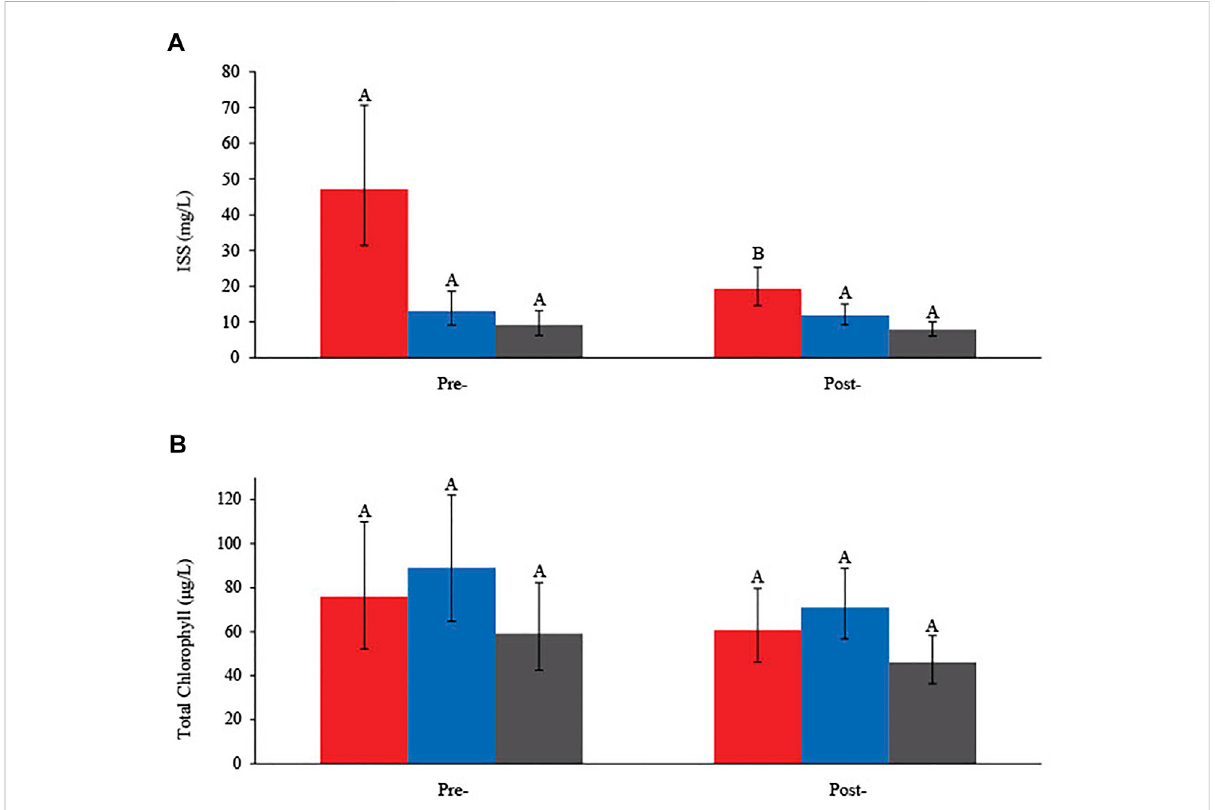
FIGURE 4 (A) Estimated marginal means (EMMs) of (A) inorganic suspended solids (ISS; mg/L) and (B) total chlorophyll ( μ g/L), with 95% con fi dence intervals, in the west (red), east 1 (blue), and east 2 (grey) units pre- (2009, 2010, and 2012) and post- (2013 – 2018) carp exclusion, Delta Marsh, Manitoba. Different letters (A and B) indicate a statistical difference between periods (pre- or post-carp exclusion) within the same marsh unit.